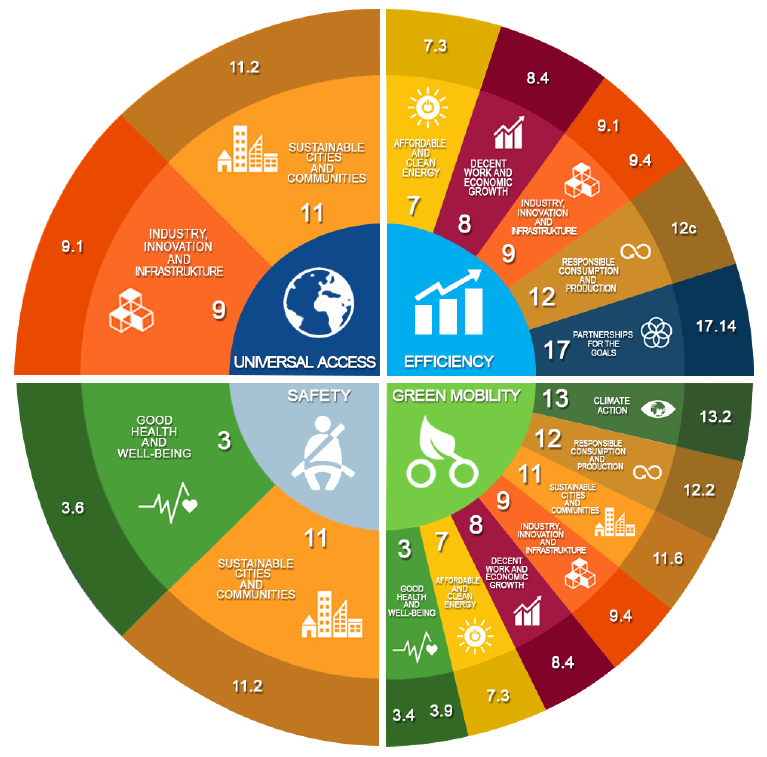
Figure 1: Classification of the SDGs related to